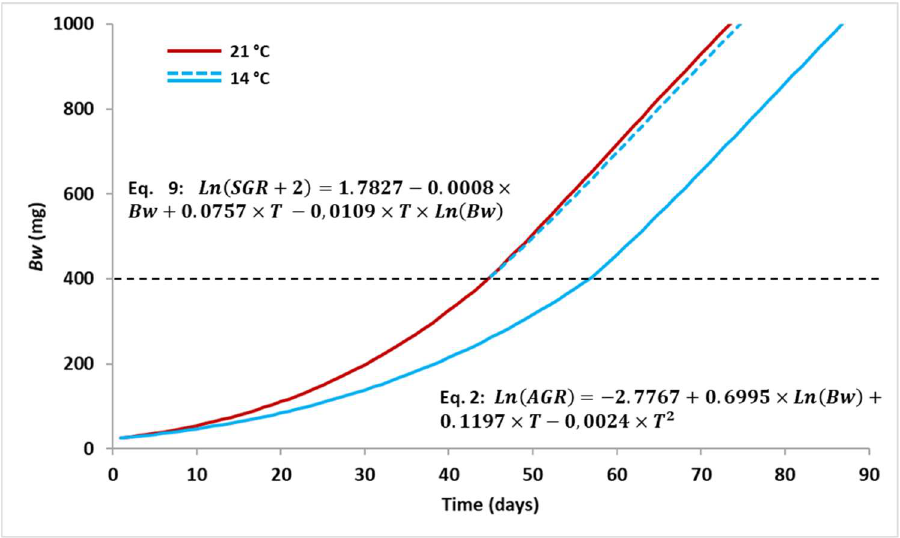
Figure 5. Simulation of individual Bw increases using the best-fitting equations under different tem- perature regimes, starting from 25 mg up to a final Bw of 1000 mg. perature regimes, starting from 25 mg up to a final Bw of 1000